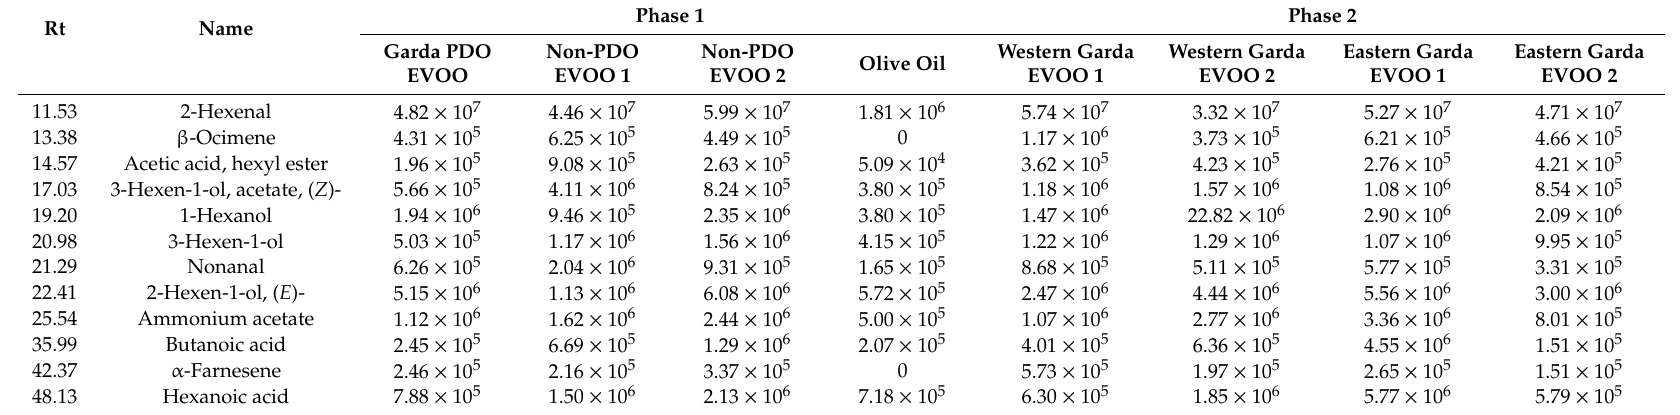
Table 1. List of common compounds for all analyzed samples, with their retention time (min) and areas of the peaks (arbitrary